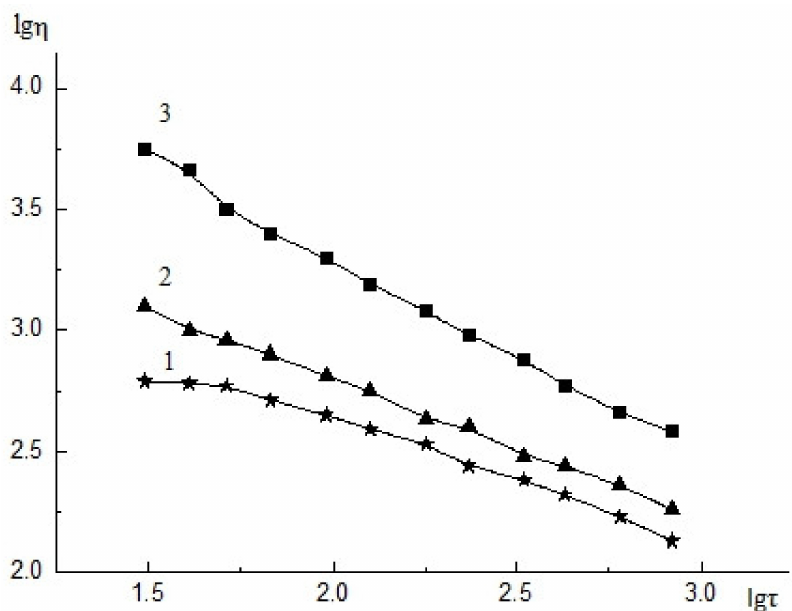
Figure 1. Flow curves of 4% ALG solution (1), 4% ALG solution with 2.5% CNW, 4% ALG solution with 7.5% CNW, 20 ◦ C, η –viscosity (mPa · s − 1 ), τ –shear stress (Pa). The relative standard deviation of the measurements did not exceed 5% ( n =